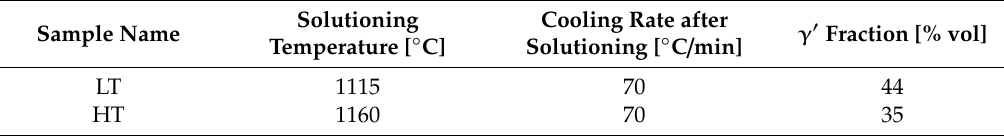
Table 2. List of solutioning